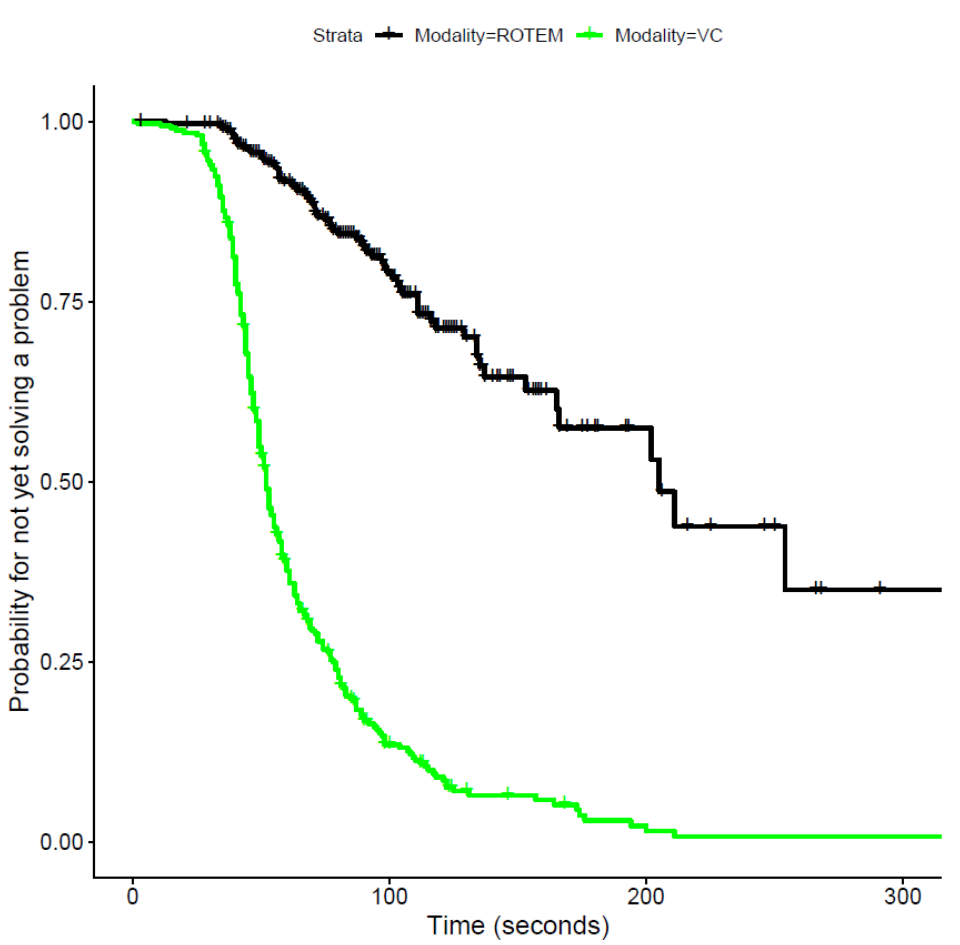
Figure 3. Kaplan – Meier curves for the time to treatment decision regarding ROTEM and Visual Clot ( p < 0.0001). The y axis describes the probability of not yet solving a problem. The faster this probability decreases, the faster the scenario can be solved. ROTEM = rotational thromboelastometry; VC = Visual Clot.